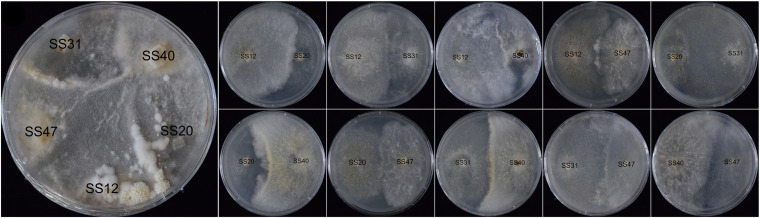
Mating reactions of non-fruiting SSIs.